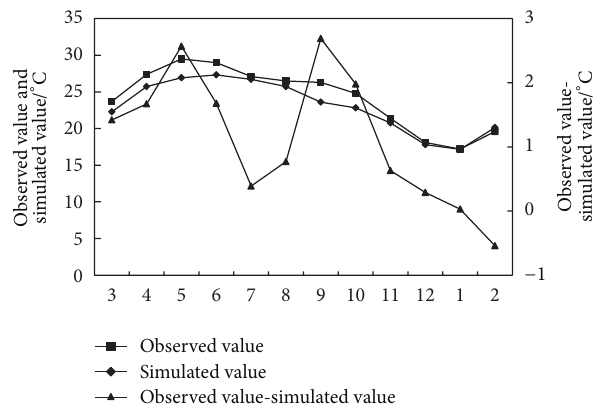
Figure 2: Simulated and observed values of the monthly average near-surface temperatures in India for the year of 2010. Note: The historical data come from http://sdwebx.worldbank.org/climate-